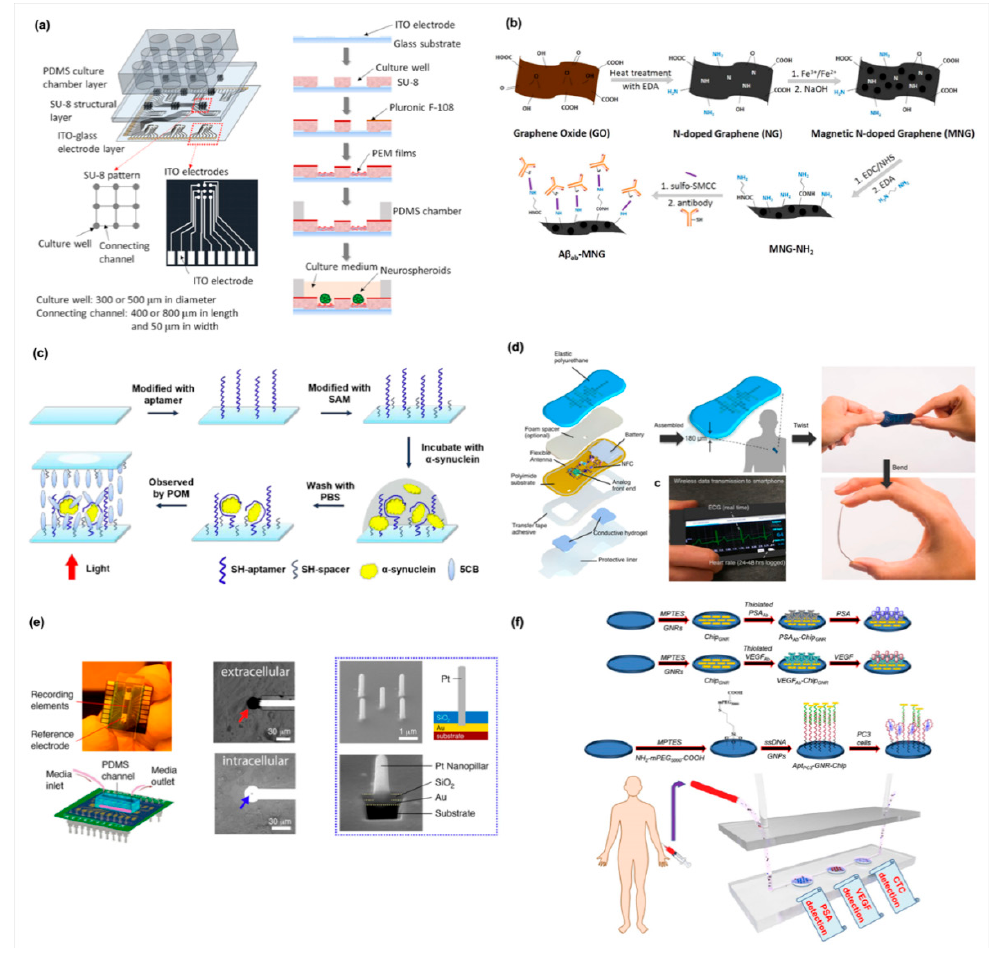
Figure 3. ( a ) Schematic illustrating the design and fabrication of a biochip by using the MEA technique. The patterned channels with Indium ion oxide (ITO)-electrodes provide a connected network enabling to guide the neurite outgrowth and measure the neurological signals through impedance signals. (Reprinted with permission from [85] Copyright (2018) ACS publications). ( b ) Illustrate the preparation of A β 42-immobilized graphene-based biosensors. The magnetic